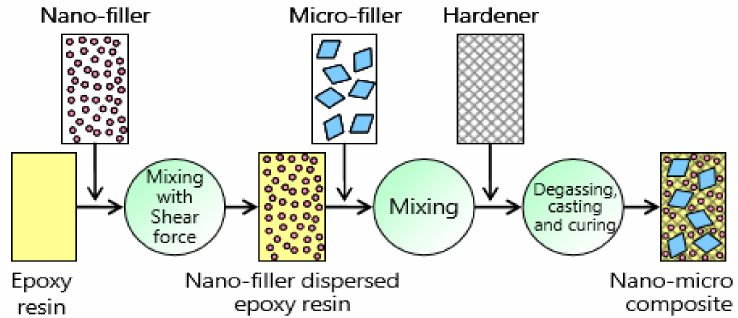
Figure 1. Scheme for the preparation of epoxy micro-nanocomposites